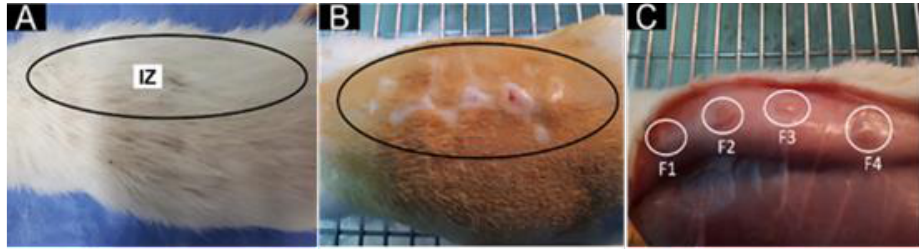
Figure 7. Macroscopic aspect of implanted areas. ( A ): Dorsal area with hair. ( B ): Dorsal area with a trichotomy. ( C ): Dorsal area, the internal area of the skin. Black ovals: implantation zone. White circles: individual implantation zones. F1 – F4: formulations 1, 2, 3, and 4.